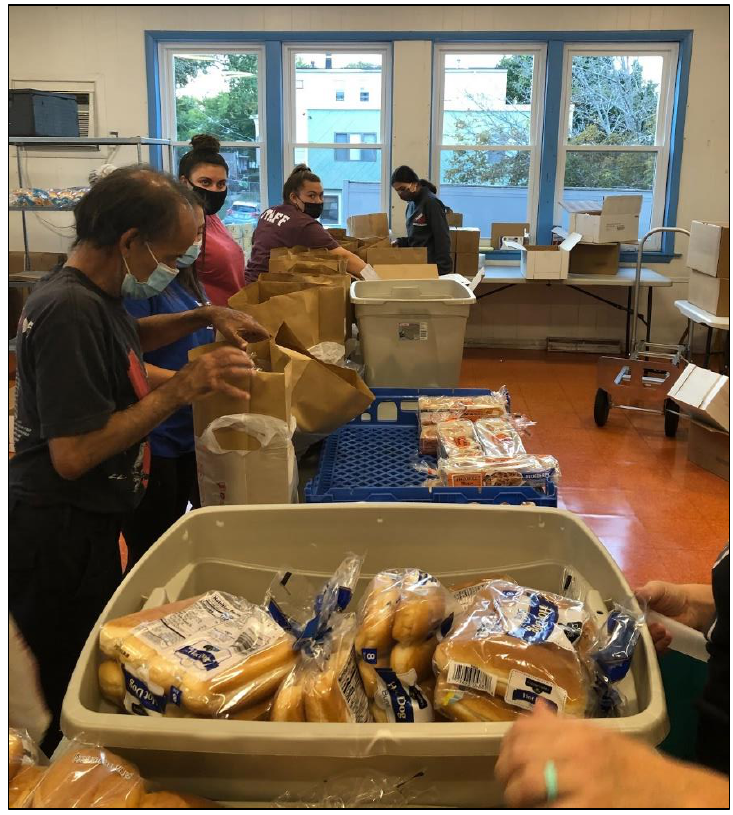
Photo courtesy of city of Revere,